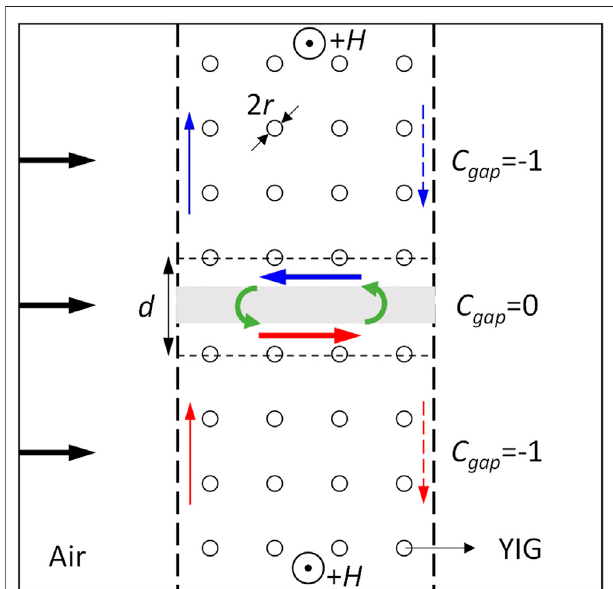
FIGURE 1 | Schematics of the GPC waveguide involving strongly coupling of two counter-propagating TPSs. The plane wave is incident along the horizontal direction from the left port (marked as black arrows), the blue and red arrows represent the transport direction of topological one-way edge states, and the green arrows indicate the strongly coupling of two counter-propagating topological one-way edge